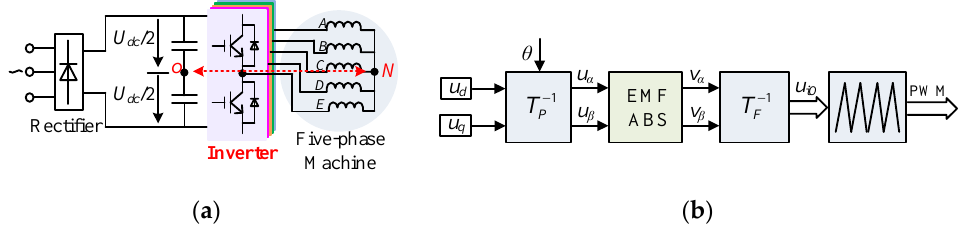
Figure 3. The fault-tolerant FOC system of five-phase motor. ( a ) Five-phase motor inverter drive system. ( b ) The way to weaken the influence of neutral point shift.